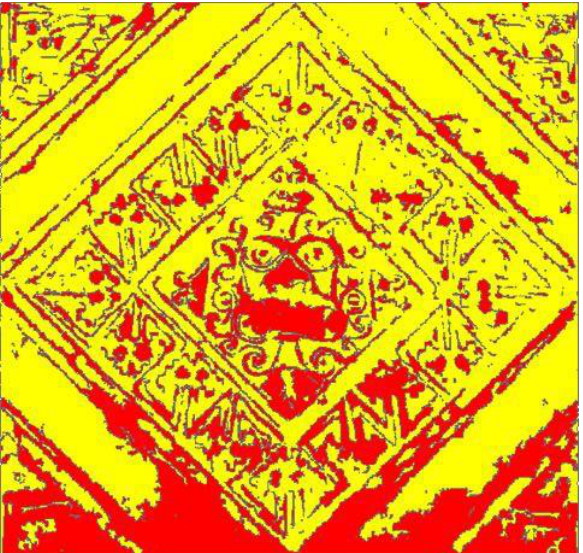
Figure 5. The supervised hard thematic map between 2006- 2017 after the winner takes all segmentation.